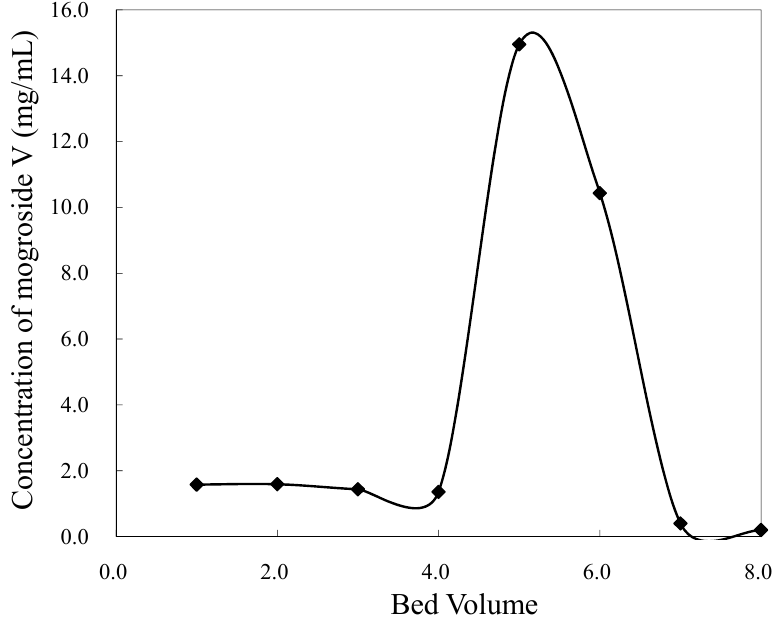
Figure 7. Elution profile of mogroside V on HZ 806